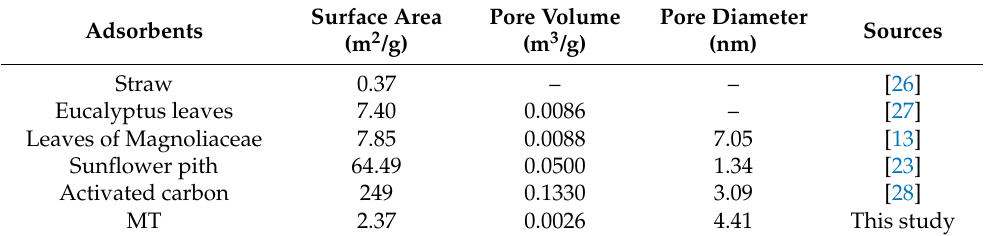
Table 1. Pore characteristics of different adsorbents.